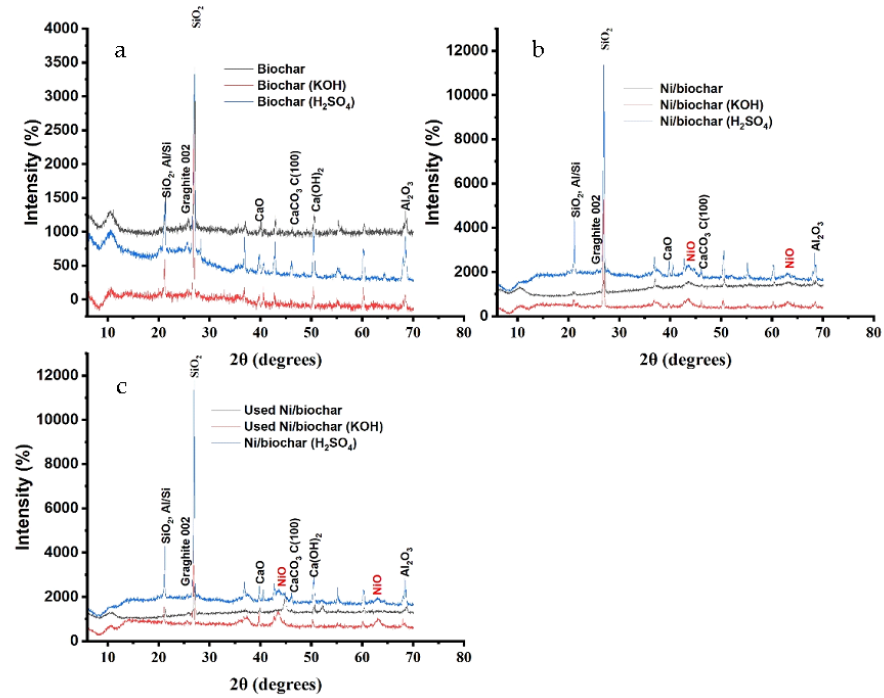
Figure 4. XRD diffraction patterns of ( a ) biochar supports, ( b ) fresh Ni/biochar catalysts, and ( c ) fresh vs. used Ni/biochar catalysts.